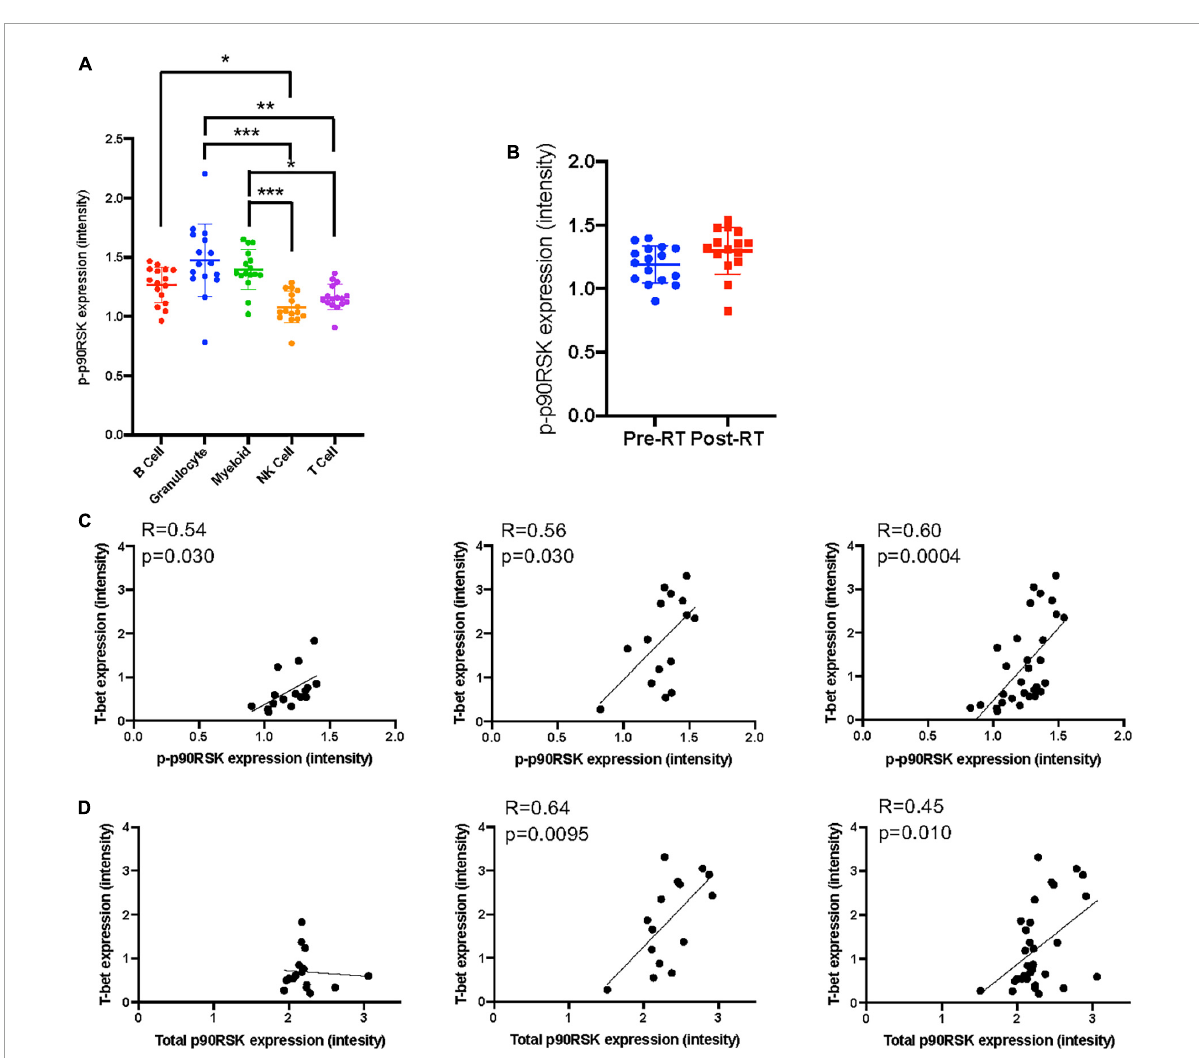
FIGURE4 The relationship between T-bet and p90RSK in Ki67 − DNMT3a + naïve B cell subset. (A) p-p90RSK expression in each cell types. Mean ± SD, * p < 0.05, ** p < 0.01, *** p < 0.001. Statistical significance was assessed by Dunn’s multiple comparisons test. (B) p-p90RSK expression in Ki67 − DNMT3a + naïve B cell subset showed no difference between pre-RT and post-RT. (C) The relationship between p-p90RSK and T-bet expression in Ki67 − DNMT3a + naïve B cell subset at pre-RT and post-RT. (D) The relationship between total p90RSK and T-bet expression in Ki67 − DNMT3a + naïve B cell subset at pre-RT and post-RT. Statistical significance and correlation were assessed by Pearson